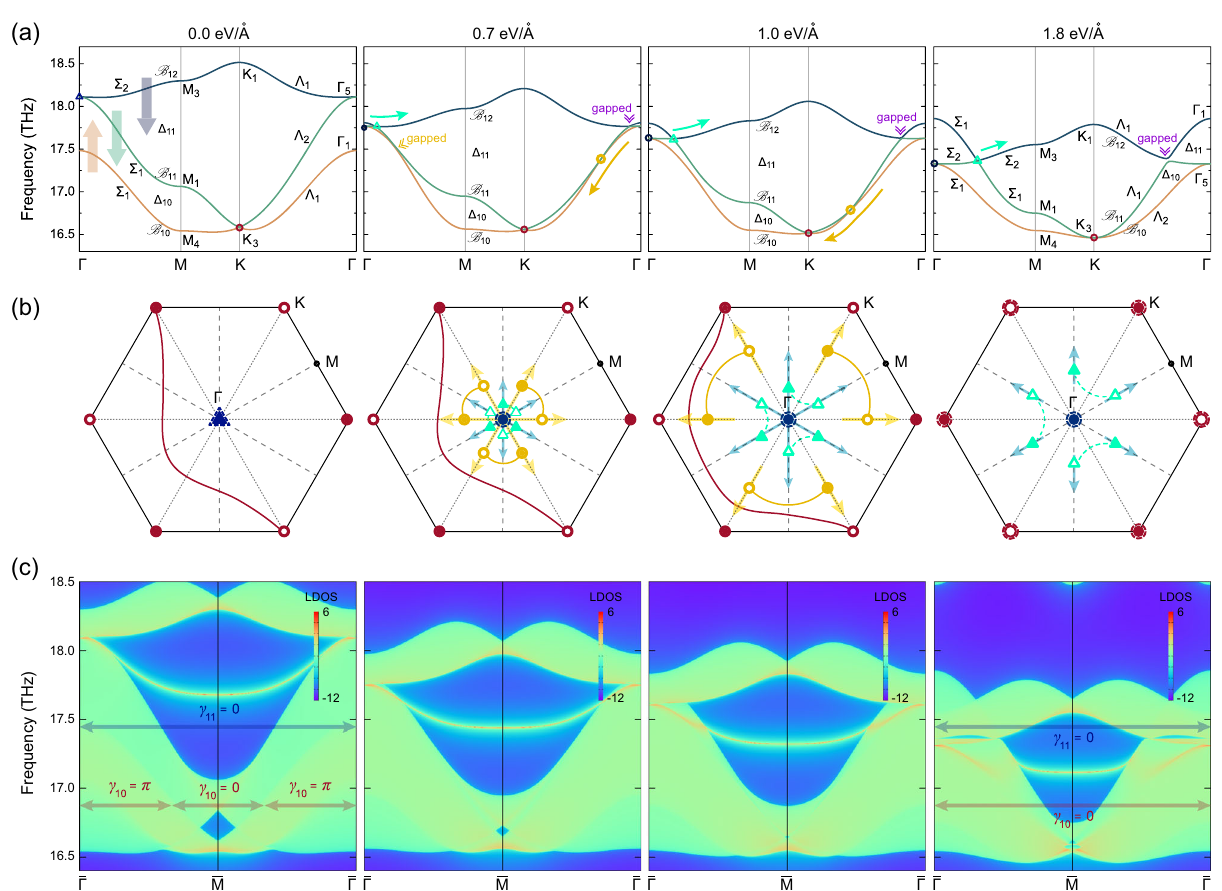
Fig. 2 Braiding of phonons in group 1. a Kagome bands and b their corresponding nodes in the 2D Brillouin zone formed by phonon branches B 10 (cid:2) 12 of 7% strained silicate under electric fi elds of 0.0 eV/ Å , 0.7 eV/ Å , 1.0 eV/ Å , and 1.8 eV/ Å . The topological con fi gurations with nodes in different gaps (different symbols) and Dirac string con fi gurations are shown in ( b ). The large blue triangle (at 0.0 eV/ Å ) and the large blue circles (at 0.7 – 1.8 eV/ Å ) with dashed boundary at Γ , as well as the large dark red circles with dashed boundary at K (at 1.8 eV/ Å ), are quadratic nodes. Note that crossing Dirac string in the same gap (same symbols) does not convert the charge and that moving nodes to the K point ensures that three charges meet in the extended zone. Hence moving the yellow nodes to K gives stable nodes with stable Euler class at K upon moving from the third to the last panel in ( b ). The corresponding phonon edge states on the (100) edge are shown in ( c ), with the {0, π }-quantised Zak phases f γ n g n bands belong to the same irrep Λ 1 . As a result, six nodes are created near the Γ point within the gap Δ 11 at 0.7 eV/ Å , as indicated by the cyan triangles in Fig. 2b.